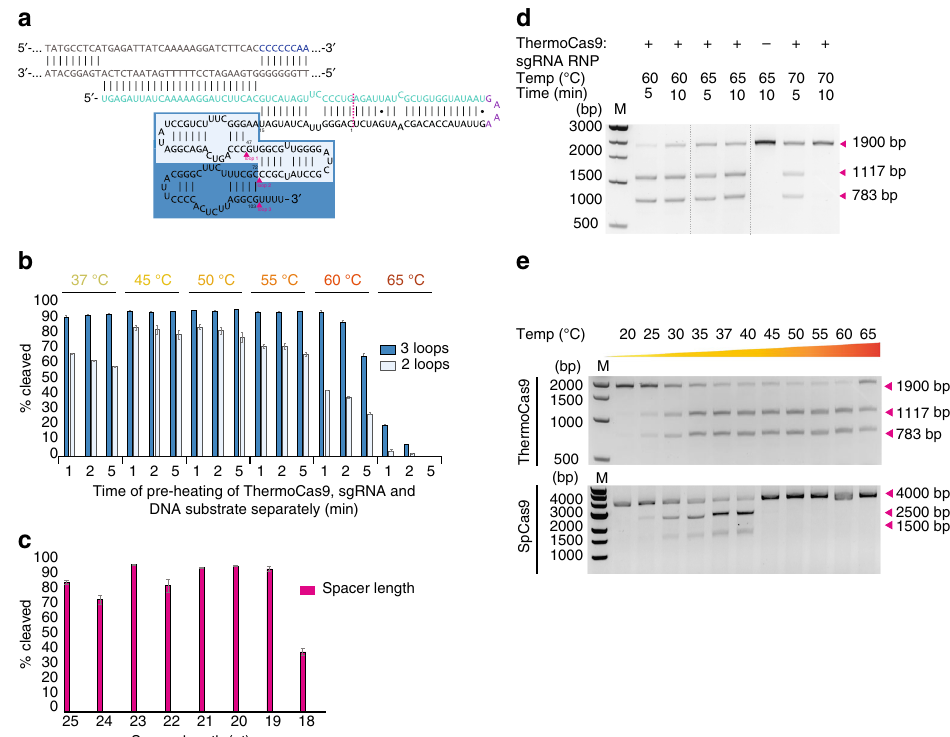
Fig. 3 ThermoCas9 temperature range and effect of sgRNA-binding. a Schematic representation of the sgRNA and a matching target DNA. The target DNA, the PAM and the crRNA are shown in gray, blue and turquoise, respectively. The site where the crRNA is linked with the tracrRNA is shown in purple. The dark blue and light blue boxes indicate the predicted three and two loops of the tracrRNA, respectively. The 41-nt truncation of the repeat-anti-repeat region and the three loops of the sgRNA are indicated by the magenta dotted line and magenta triangles, respectively. b The importance of the predicted three stem-loops of the tracrRNA scaffold was tested by transcribing truncated variants of the sgRNA and evaluating their ability to guide ThermoCas9 to cleave target DNA at various temperatures. Average values of three replicates are shown, with error bars representing S.D. The blots of one of the replicates are shown in Supplementary Fig. 10. c The importance of the length of the spacer was tested by transcribing truncated variants of the initial spacer in the sgRNA and evaluating their ability to guide ThermoCas9 to cleave target DNA at 55°C. Average values of three replicates are shown, with error bars representing S. D.. The blots of one of the replicates are shown in Supplementary Fig. 11. d To identify the maximum temperature, endonuclease activity of ThermoCas9: sgRNA RNP complex was assayed after incubation at 60, 65, and 70°C for 5 or 10 min. The pre-heated DNA substrate was added and the reaction was incubated for 1 h at the corresponding temperature. e Comparison of active temperature range of ThermoCas9 and SpCas9 by activity assays conducted after 5 min of incubation at the indicated temperature. The pre-heated DNA substrate was added and the reaction was incubated for 1 h at the